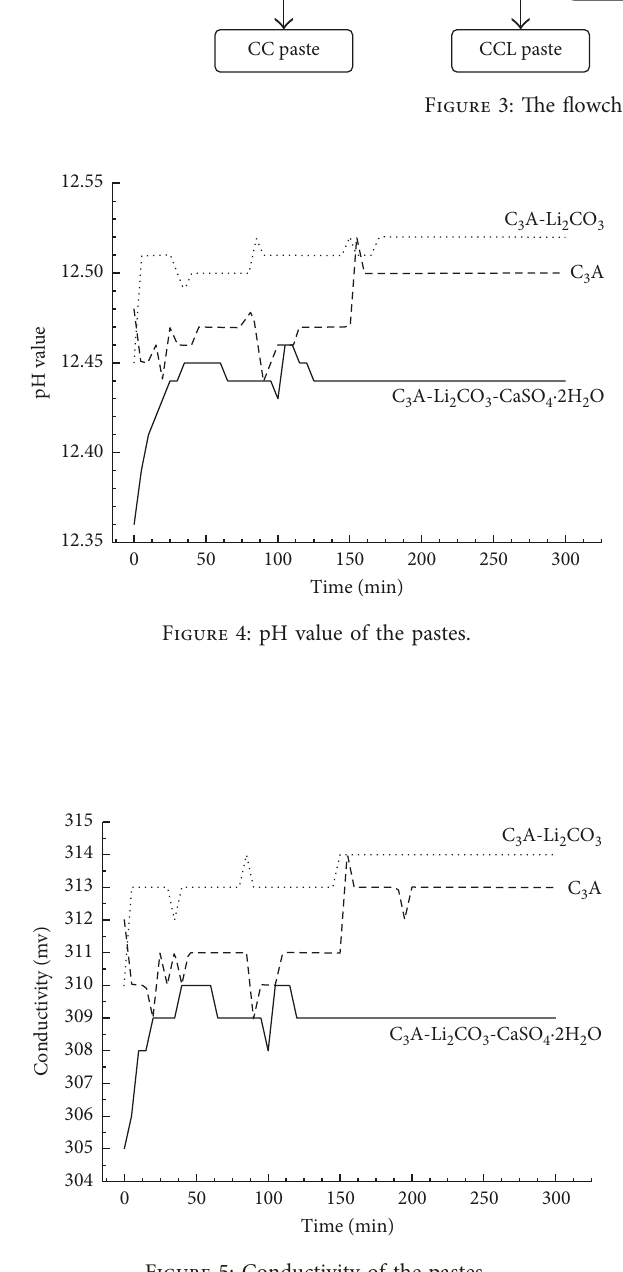
Figure 5: Conductivity of the